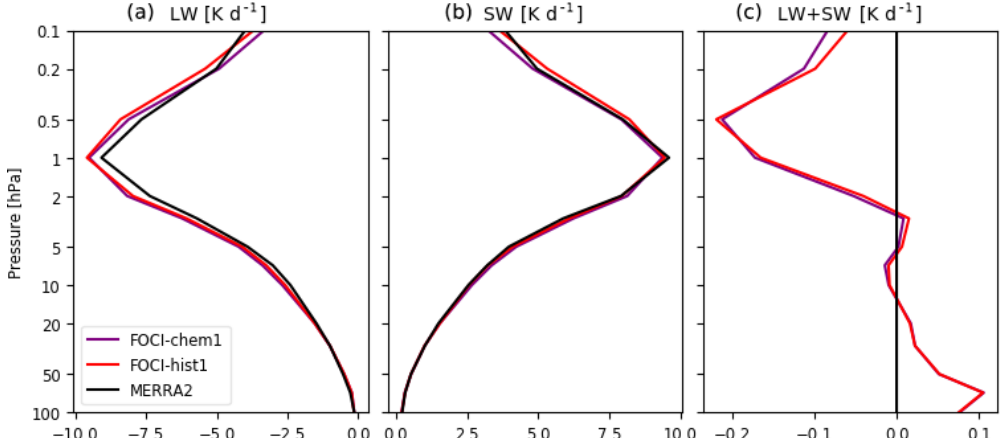
Figure A5. Global average vertical profile of longwave (LW, a ), shortwave (SW, b ) and net SW plus LW heating rates (c) in FOCI-hist1, FOCI-chem1 and MERRA2 reanalysis data from 1980 to 2013.